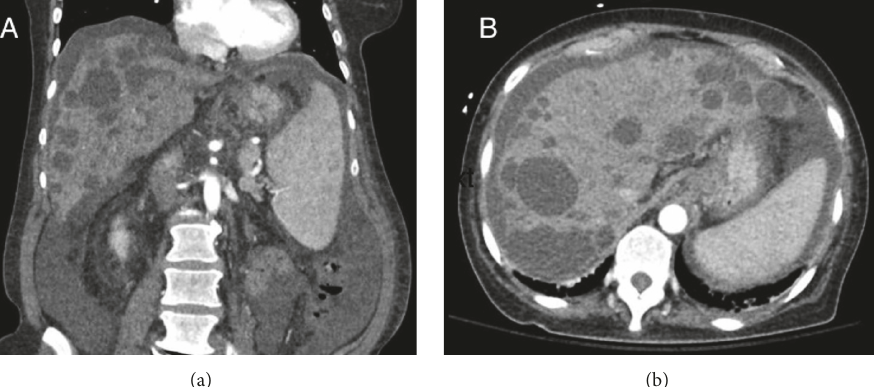
Figure 2: Computed tomography of abdomen and pelvis (coronal and axial scans) showing polycystic liver disease along with evidence of portal hypertension in form of splenomegaly and